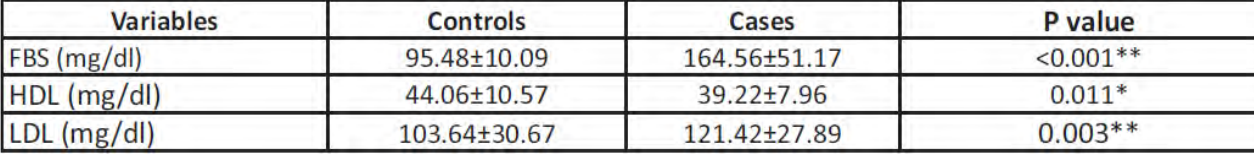
Table 3: Comparison of blood